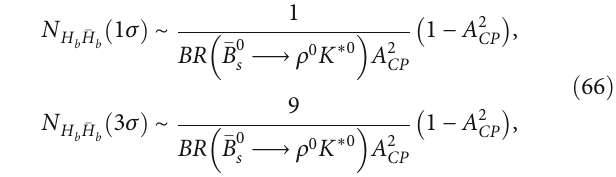
Figure 6: The branching ratio, BR ð (cid:1) B 0 dashed line correspond to the maximum, middle, and minimum CKM matrix elements for the decay channel of